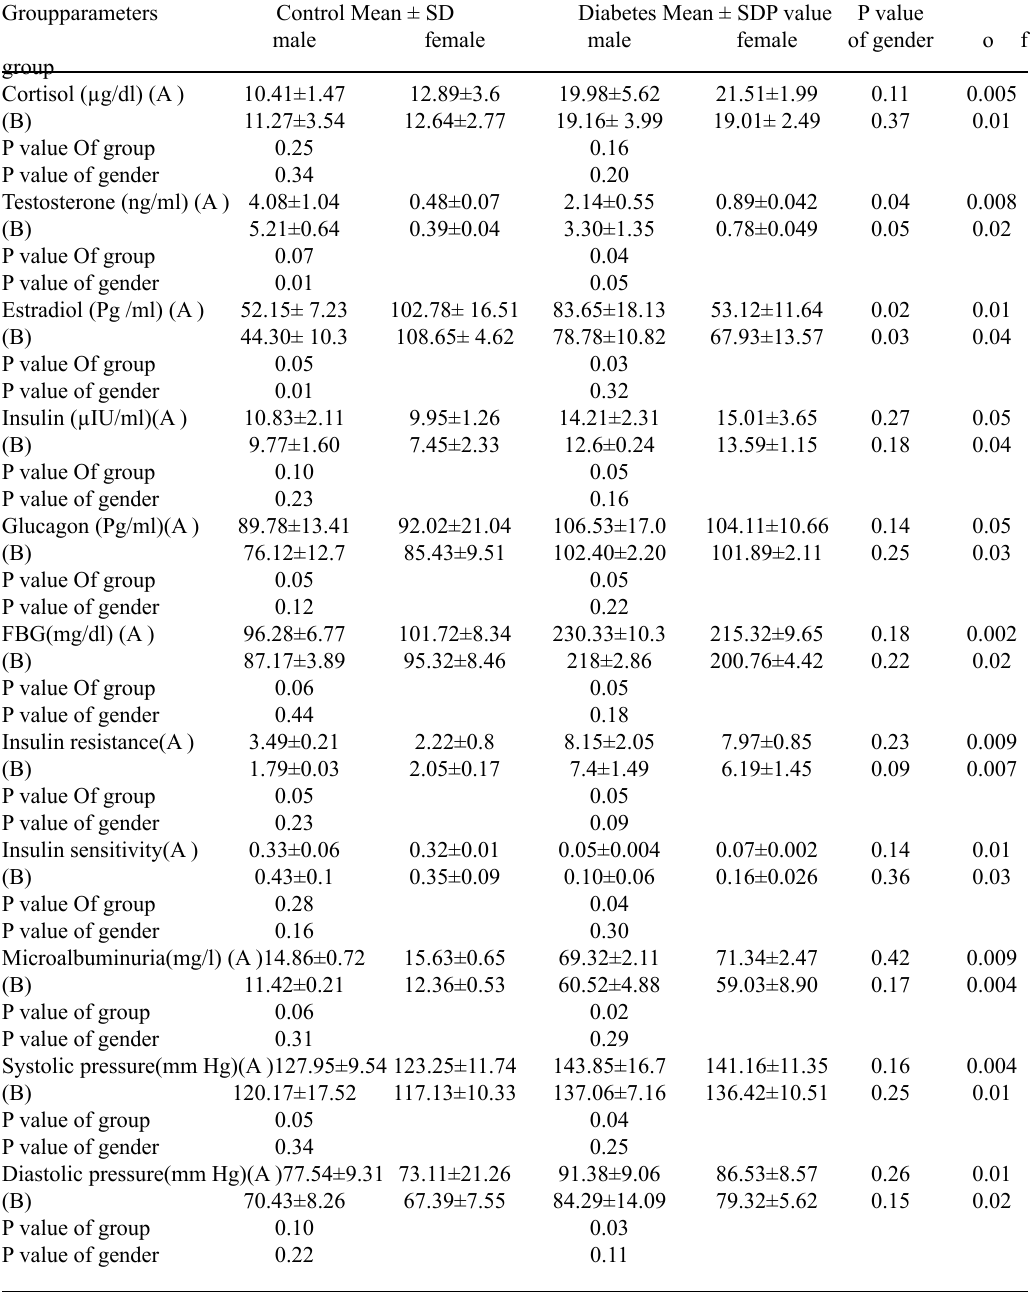
table 3. Role of MIR-196a2 in some hormonal and physiological parameters levels rate in type 2 diabetic patients and control